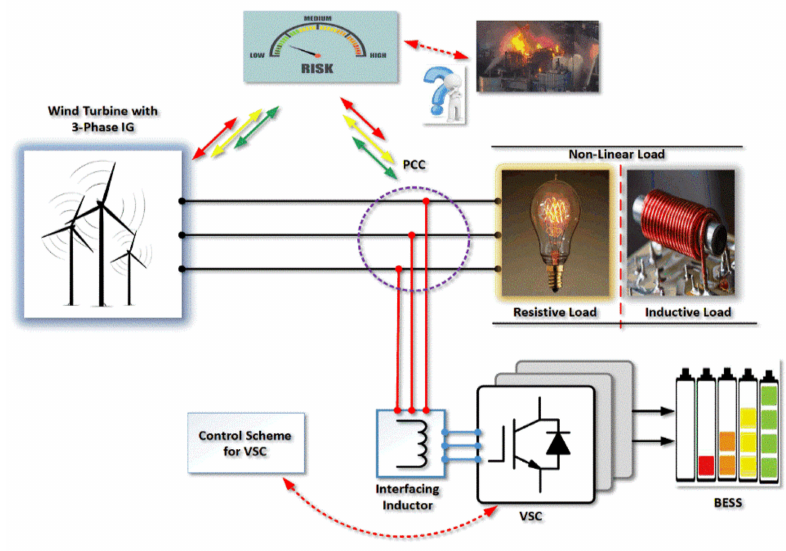
Figure 3. Graphical representation of overall system configuration.